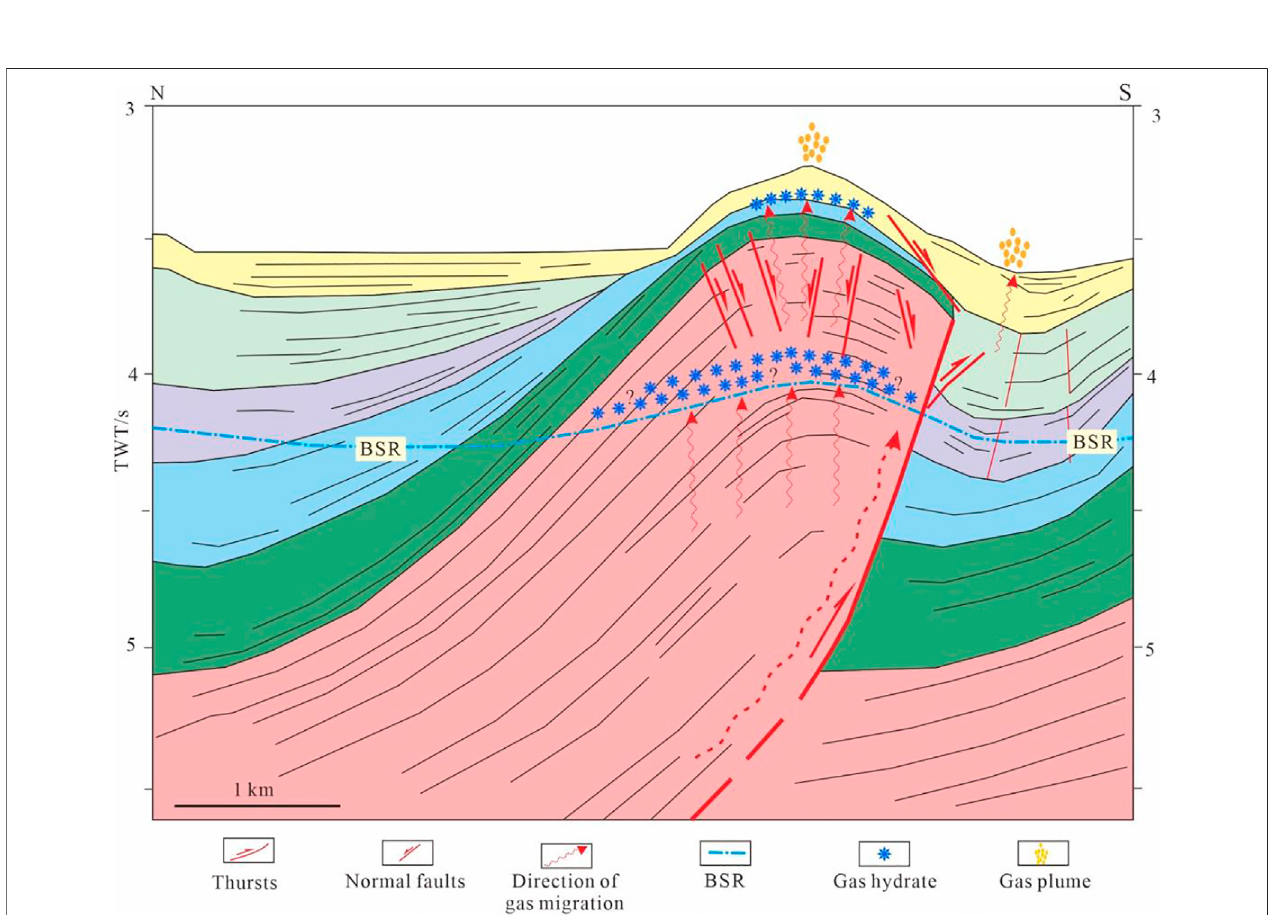
FIGURE 2 | Gas hydrate accumulation model of a two-story structure in the Makran Accretionary Prism (modi fi ed after Grando and McCla, 2007; Gong et al., 2018a).